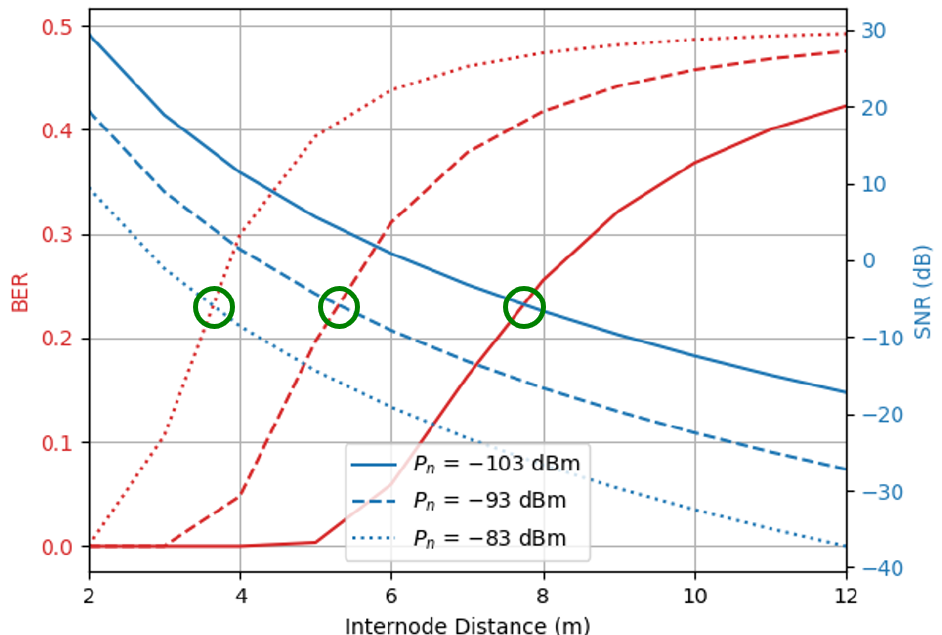
Figure 6. Variation of the SNR and BER with the internode distance at a fixed high noise power ( 𝑃 𝑛 = −83 𝑑𝐵𝑚 ), the average noise power ( 𝑃 𝑛 = −93 𝑑𝐵𝑚 ) and a low noise power ( 𝑃 𝑛 = −103 𝑑𝐵𝑚 ).